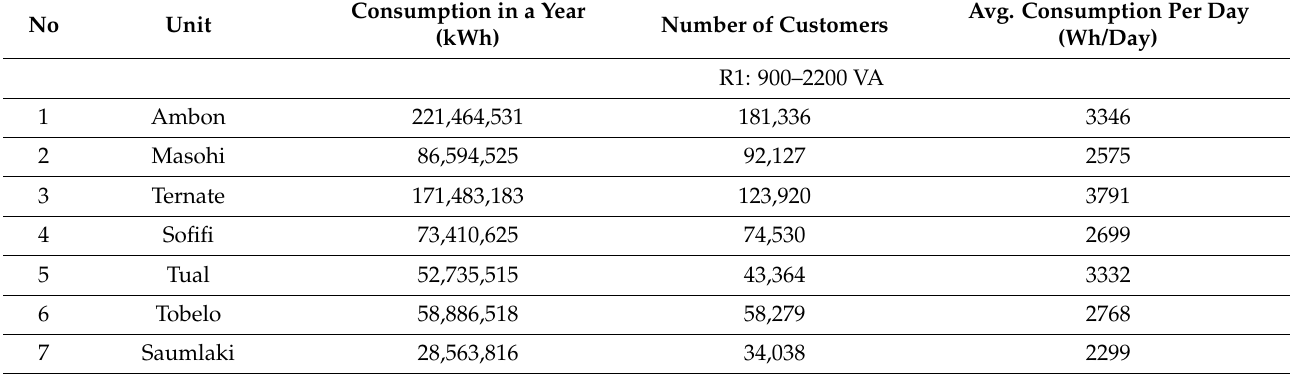
Table A2. Maluku and North Maluku household electricity consumption throughout the year 2020 (PLN